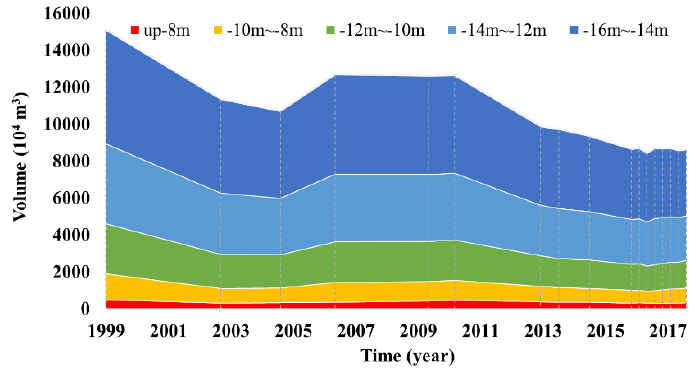
Figure 6. The historical volumes of the main body of JJS above elevation −16 m.